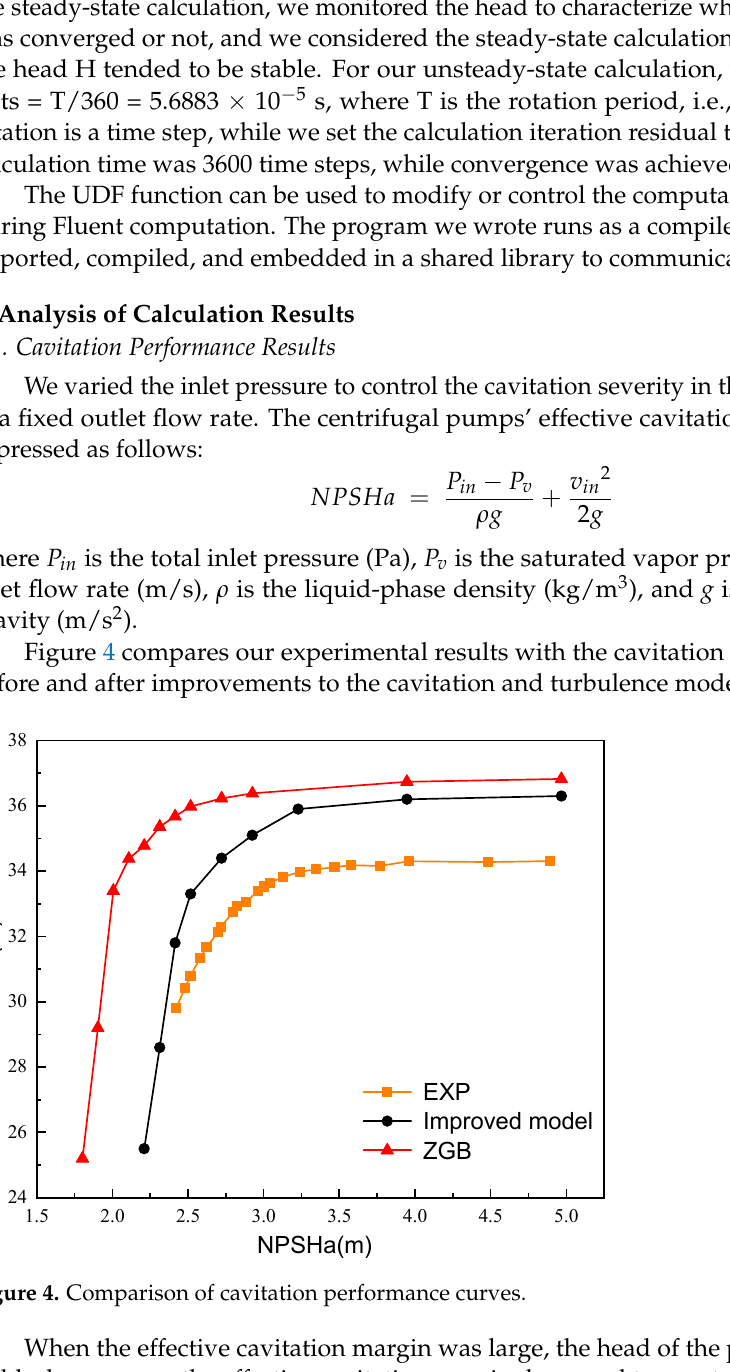
Table 2. Boundary condition setting of the computational domain.